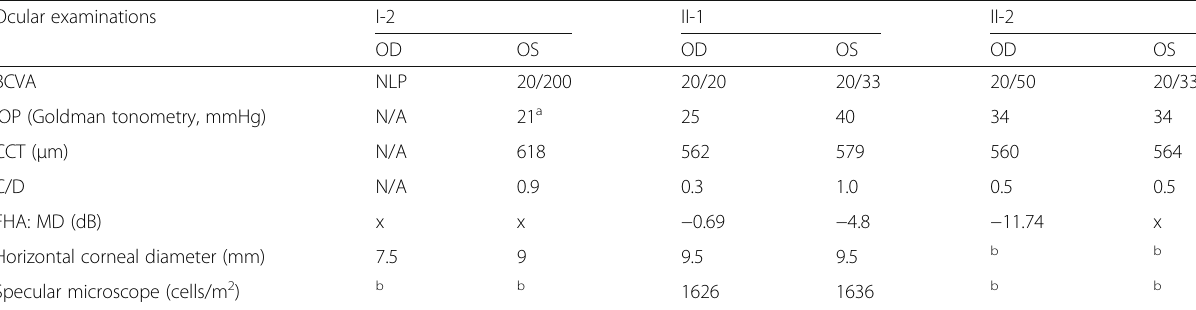
Table 2 Ocular examinations of affected family members with Axenfeld-Rieger Syndrome Ocular